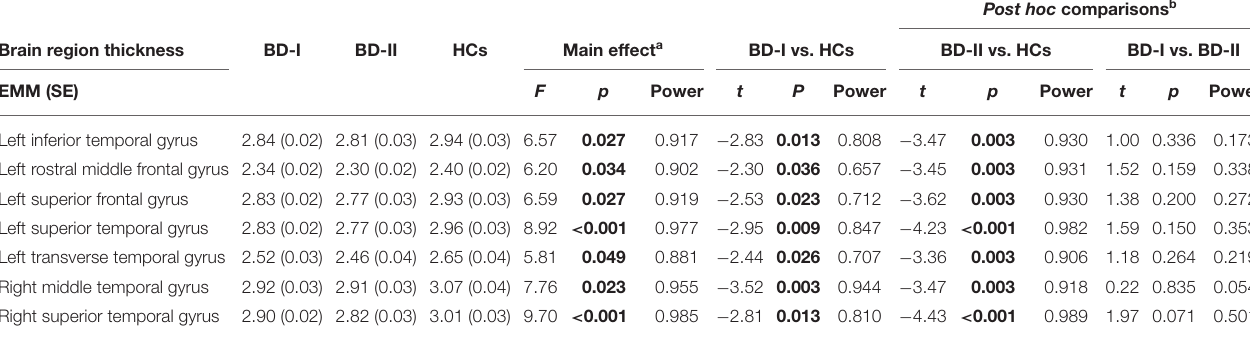
Post hoc comparisons b